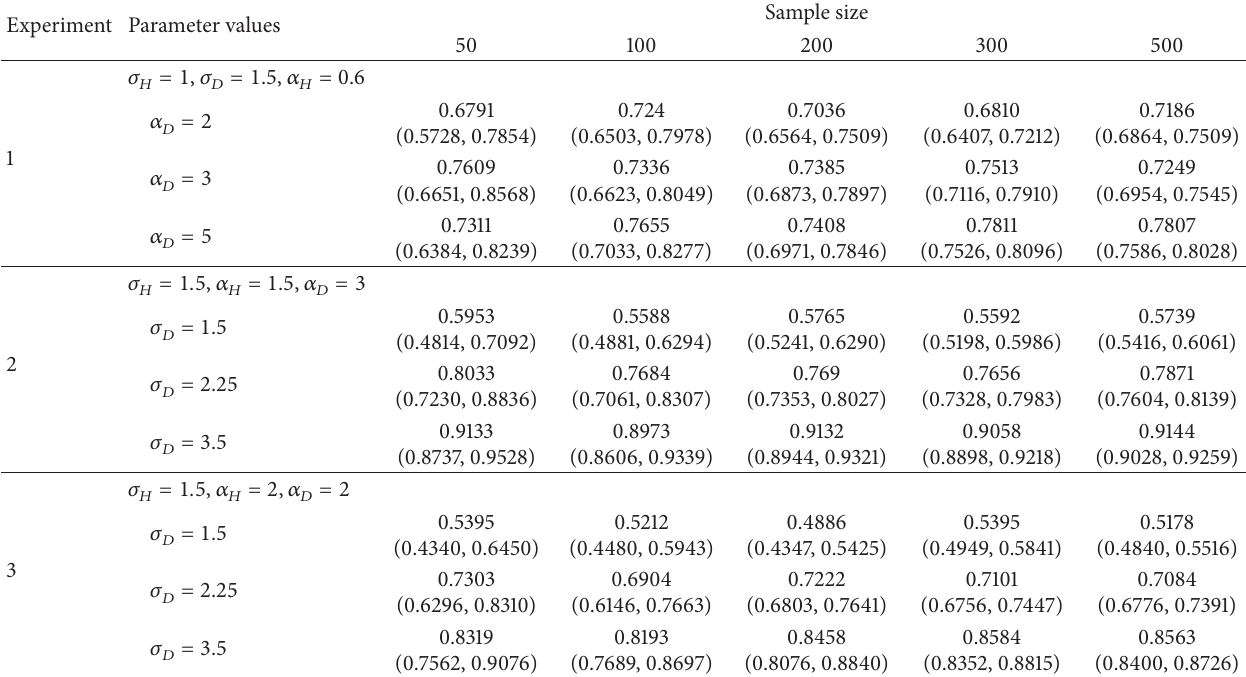
Table 1: Confidence intervals for AUC at various combinations of scale and shape parameters of normal and abnormal populations with different sample